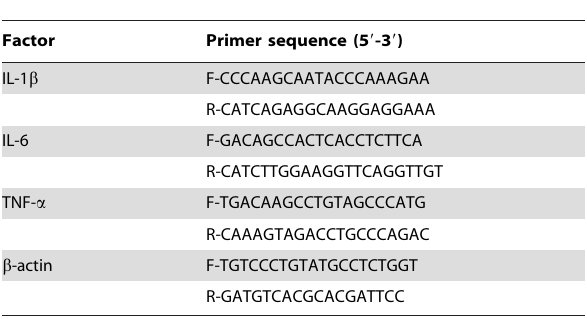
Table 2. Primers pairs used in this